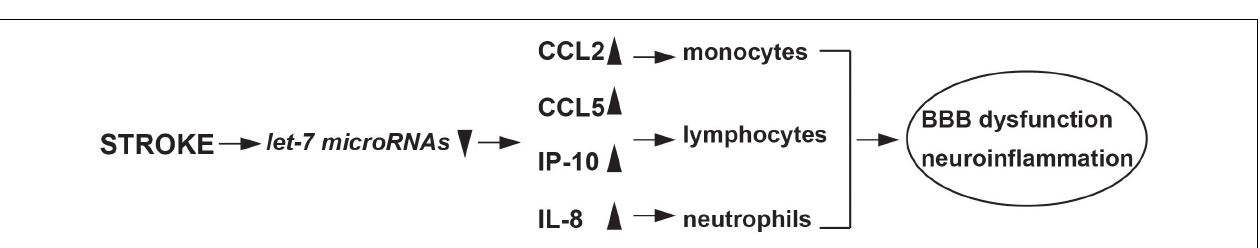
FIGURE 3 | let-7g* attenuates vascular damage after tMCAO. Cerebral neurovasculature following sham control or stroke was imaged with MicroCT, as detailed in section “Materials and Methods” (A) . In right (tMCAO) hemisphere, the mean perfused vessel thickness was measured relative to control hemisphere (B) , total volume of vascularized brain tissue (C) , vascular surface area relative to perfused volume (D) , and the number of patent branches originating from the right middle cerebral artery (E) . Data are shown as mean ± SD. ∗ p < 0.05. Scale bar = 1 mm.